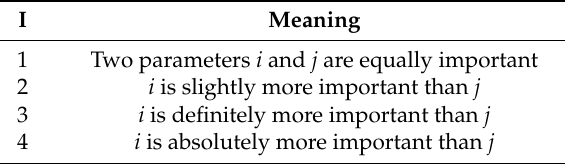
Indicator scale selected for the Analytical Hierarchy Process (AHP) pairwise comparison